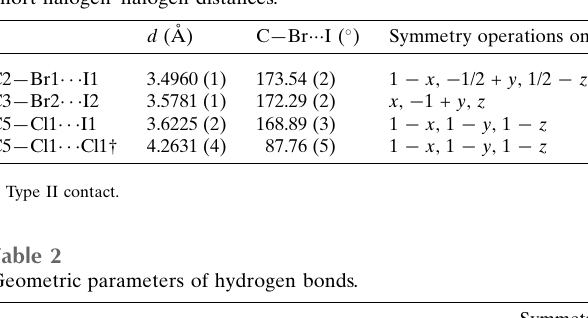
Symmetry operations on Figure 4 Hirshfeld surface of a Br 4 Q molecule with closest-neighbour atoms colour coded: H – grey, C – black, O – red, Cl – green, Br – brown and I – purple.